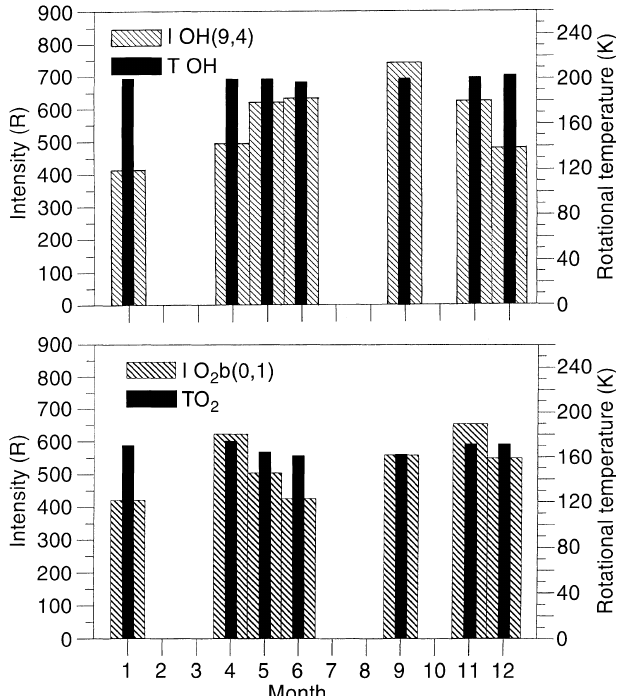
Fig. 2. Monthly means of the OH (cid:133) 9 ; 4 (cid:134) and O 2 b (cid:133) 0 ; 0 (cid:134) intensities and T(OH) and T (cid:133)